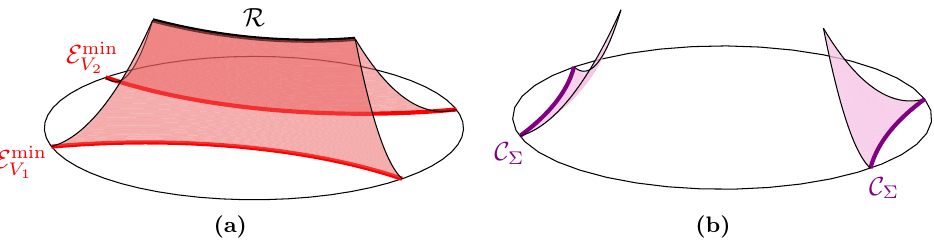
and E min (cf. eq. (3.16)). The V 1 V 2